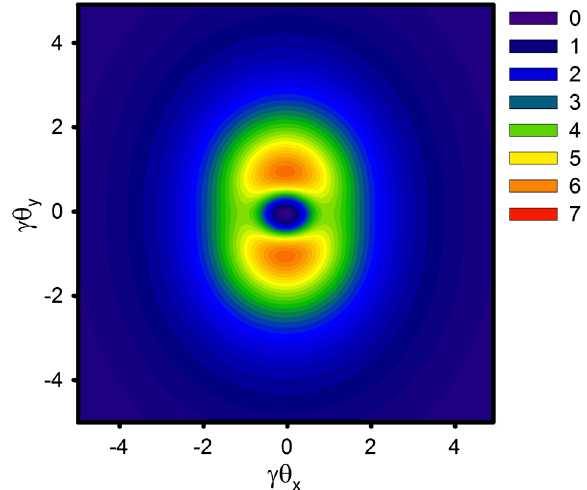
FIG. 2. Angular intensity distribution of BTR generated by 10 10 electrons in the molybdenum target with the tilt angle α ¼ 28 . 1 °. The electron energy is 855 MeV, and the radiation wavelength is 20